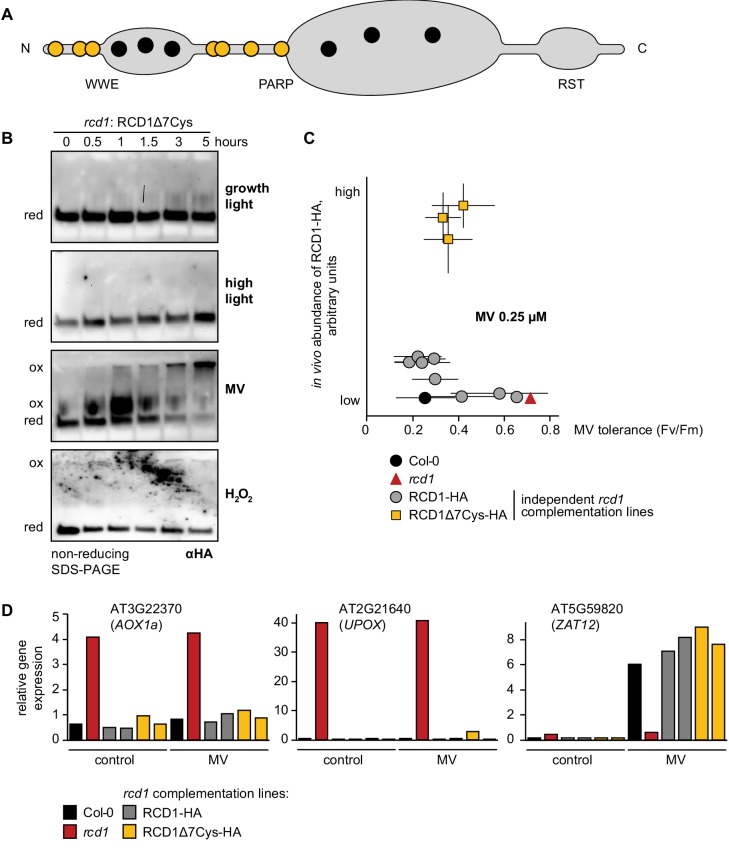
Characterization of the rcd1: RCD1Δ7Cys-HA lines.(A) Domain structure of RCD1 with the positions of cysteine residues shown with circles. Interdomain cysteines mutated in the RCD1Δ7Cys-HA lines (RCD1Δ7Cys = RCD1 C14A-C37A-C50A-C175A-C179A-C212A-C243A) are shown in yellow. (B) The rcd1 complementation line expressing the RCD1Δ7Cys-HA variant under the control of the native RCD1 promoter was treated with high light, MV or H2O2 as described in Figure 2. In this line accumulation of high-molecular-weight RCD1 aggregates observed in RCD1-HA line (Figure 2B) was largely abolished. Reduced (red) and oxidized (ox) forms of the protein are labeled. To ascertain that all HA-tagged protein including that forming high-molecular-weight aggregates has been detected by immunoblotting, the transfer to a membrane was performed using the entire SDS-PAGE gel including the stacking gel and the well pockets. The experiment was performed three times with similar results. (C) Independent single-insertion homozygous rcd1 complementation lines expressing RCD1Δ7Cys-HA were compared to those expressing RCD1-HA as described in Figure 1—figure supplement 1D. In all the tested lines, RCD1Δ7Cys-HA accumulated to higher amounts than the wild-type RCD1-HA as revealed by immunoblotting with αHA antibody. MV tolerance of the RCD1Δ7Cys-HA lines was not different from that of the RCD1-HA lines or Col-0. Source data and statistics are presented in Figure 2—source data 1. (D) Expression of RCD1-regulated genes was measured by real time quantitative PCR in Col-0, rcd1, two rcd1: RCD1-HA lines expressing high levels of RCD1-HA and two lines expressing RCD1Δ7Cys-HA. No difference in expression of the selected RCD1-regulated genes AOX1a (AT3G22370), UPOX (AT2G21640), or the stress-induced gene ZAT12 (AT5G59820) was detected in the rcd1: RCD1Δ7Cys-HA line as compared to rcd1: RCD1-HA or Col-0. For MV treatment detached rosettes were soaked in 1 μM MV overnight in the darkness and then exposed to 1 hr of white luminescent light of 220–250 µmol m−2 s−1. Note that inactivation of RCD1 prevented induction of a general stress marker gene ZAT12 in response to MV. Five rosettes were pooled together for each sample. The experiment was repeated twice with similar results. Source data and statistics are presented in Figure 2—source data 1.